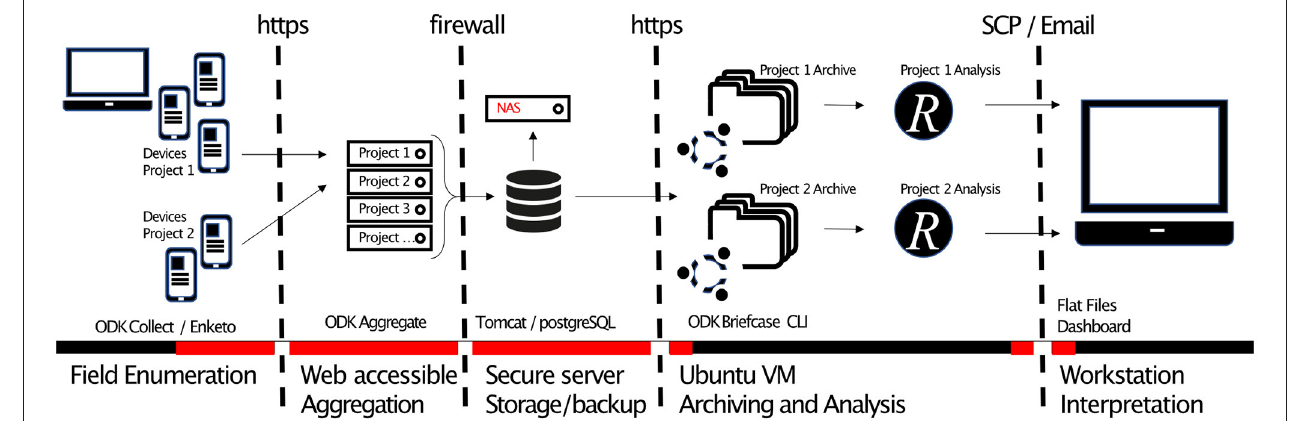
FIGURE 2 | System design of the LSHTM Emergency and Epidemic Data Kit. Devices in the field are used to carry out data collection (enumeration) activities on browsers or an Android App. Those using Android have the option to register ISO/IEC 19794-2 fingerprint templates as part of the data collection. Encrypted records are submitted to one of many parallel web accessible ODK Aggregate server front-ends. All servers lead to a single PostgreSQL database and backup system. All backups contain only encrypted, non-human-readable form data. An Ubuntu virtual machine is scheduled to perform archiving (data pull, decrypt and export activities, including optionally analysis of fingerprint templates) and triggers analysis (data tidying, analysis, and report generation) using R , R markdown and other open-source analytics tools. Outputs are securely copied or emailed to a workstation for end-user interactions. Areas highlighted in red show where data are stored or transferred in encrypted formats and are non-human